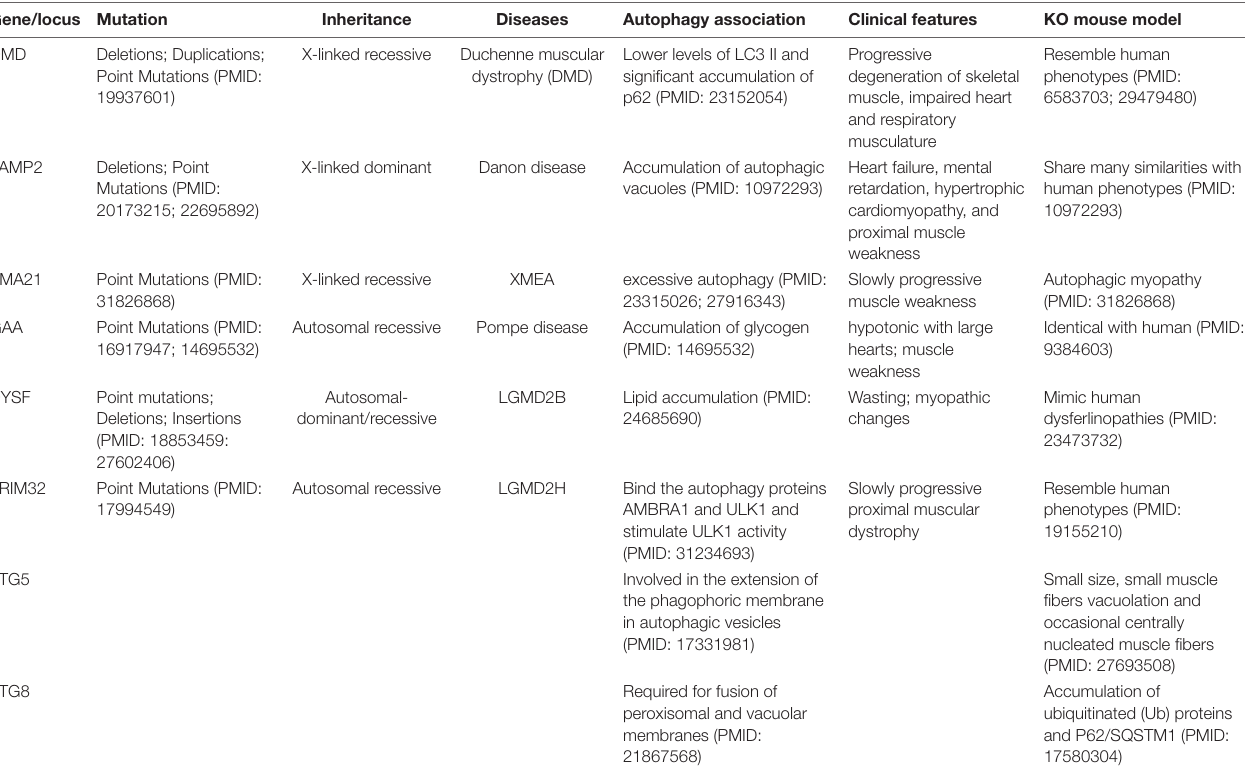
Gene/locus Mutation